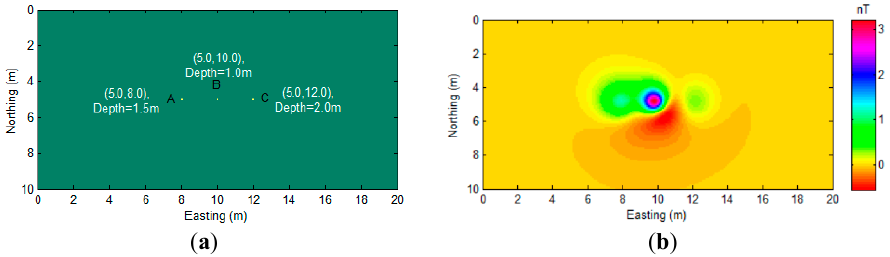
Figure 8. ( a ) Plain sectional view of synthetic model where source A: I = 70 ◦ , D = 30 ◦ , and source B: I = 60 ◦ , D = 40 ◦ , and source C: I = 80 ◦ , D = 20 ◦ ; dipole moments are 20 Am 2 ; and ( b ) Magnetic anomaly field.